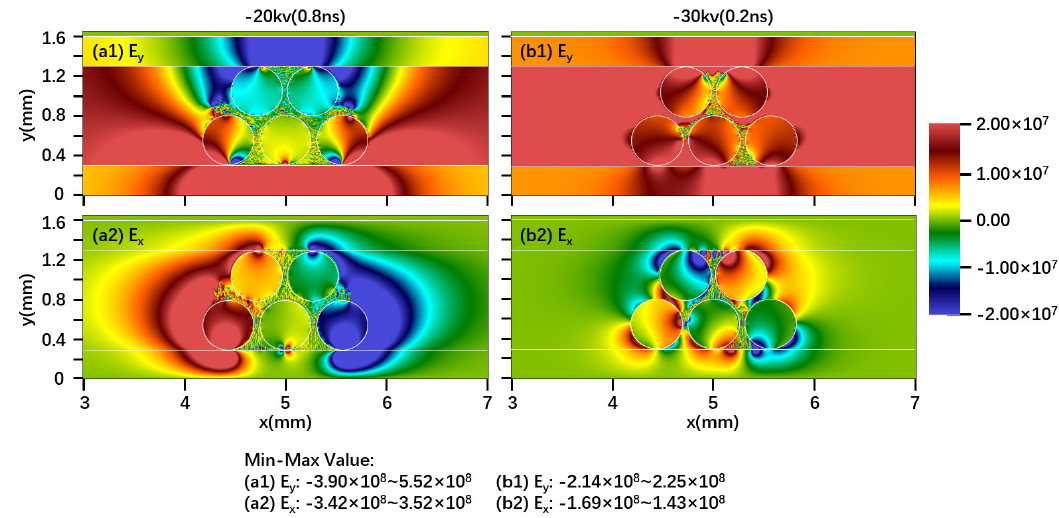
Figure 7. Electric field components in the y and x direction, ( a1 , b1 ) E y (V/m) and ( a2 , b2 ) E x (V/m), ( a1 , a2 ) for − 20 kV (0.8 ns), and ( b1 , b2 ) for − 30 kV (0.2 ns), in an air discharge. The maximum values are noted under the figure. They occur at the contact points between the beads, and are larger than the color scale, but the color scale is chosen in such a way to better illustrate the general